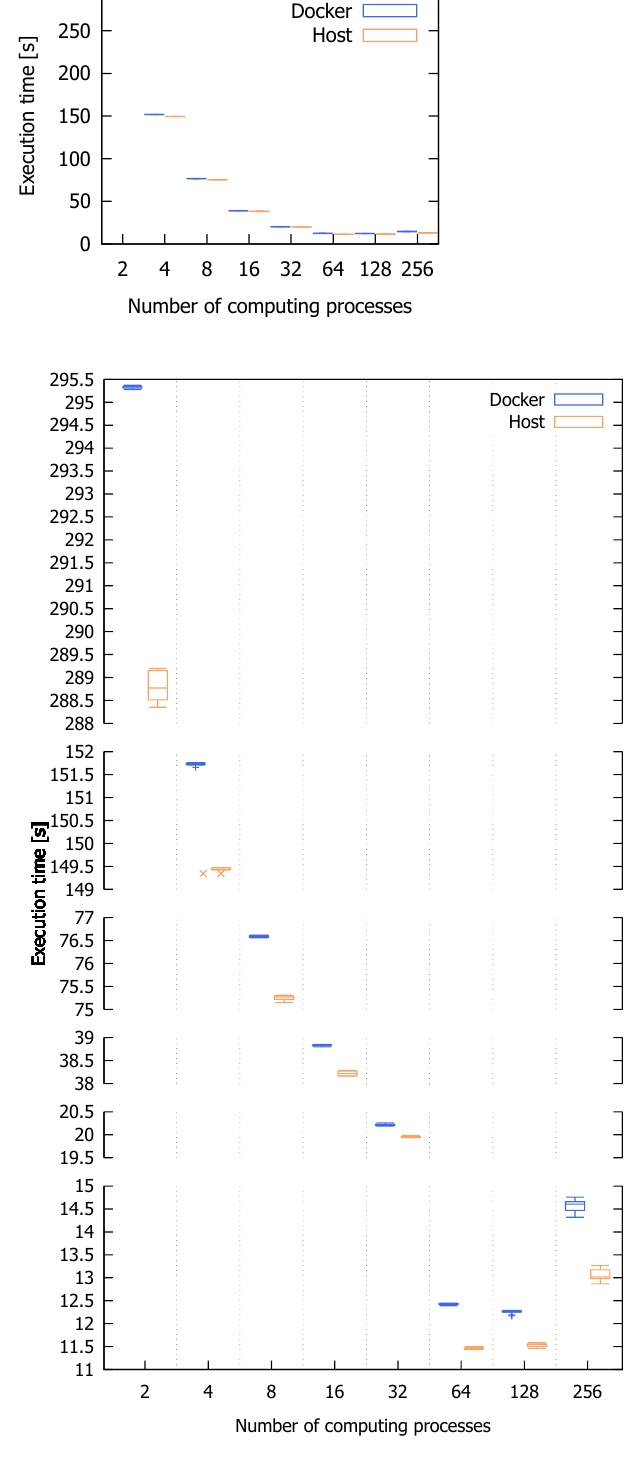
Figure 5. Execution times for MasterSlave, -O3 compilation flag; boxplot notation: medians, Q1 and Q3, max(Q1 − 1.5IQR, minimum) and min(Q3+1.5IQR, maximum) as well as potential outliers (+ for Docker, x for